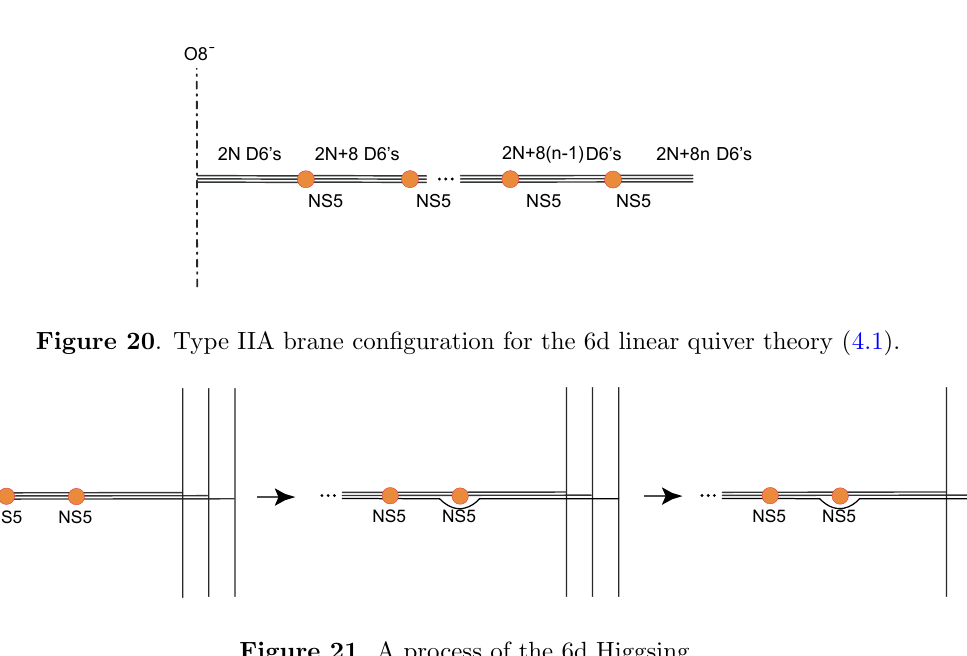
Figure 21 . A process of the 6d